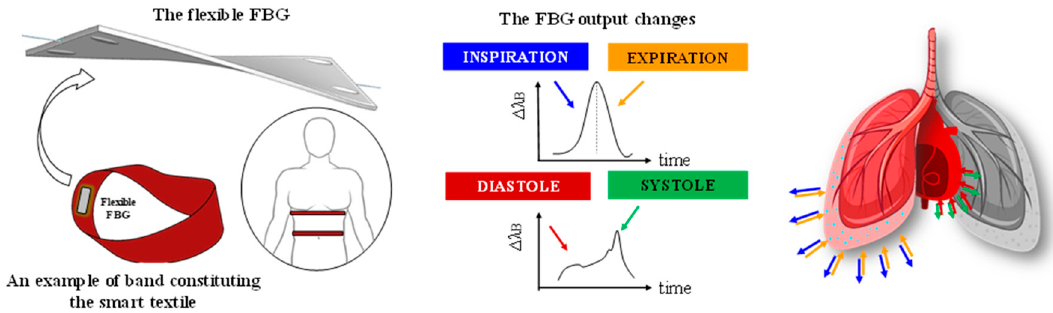
Figure 1. Schematic representation of the sensing element and the smart textile with typical FBG output changes induced by breathing and heart beating.